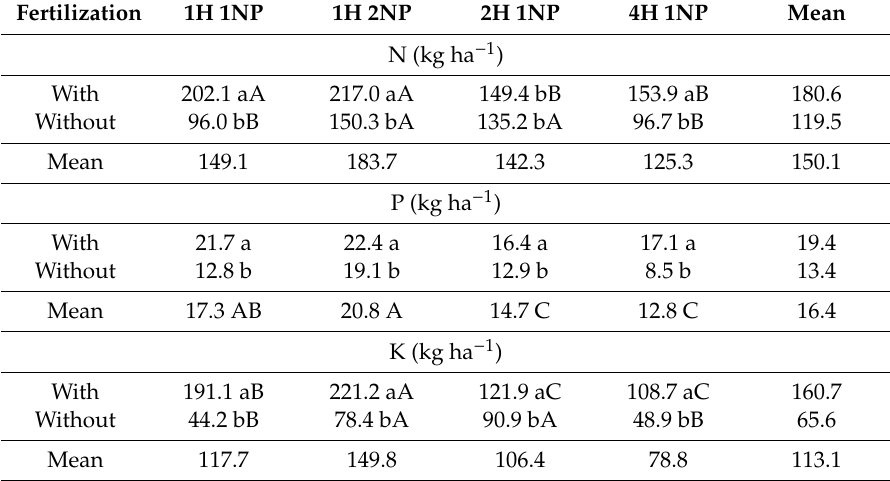
Table 5. Amounts of N, P, K, Ca and Mg in the above ground portion of the clone GG157, at 60 months of age, in response to liming / fertilization (With or Without) and height (H) and number (NP) of poles per stump at the time of pole